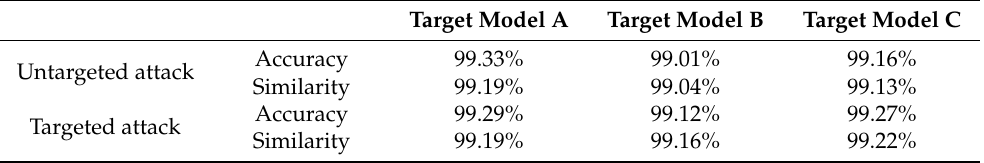
Table 3. Training results of the surrogate model.